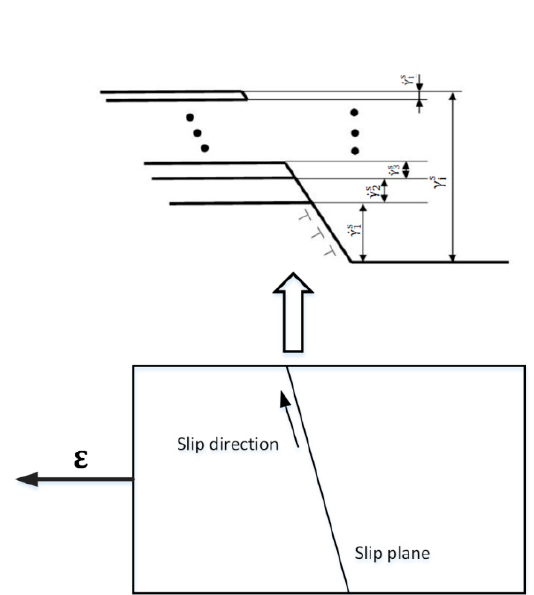
γ  . γ s and the shear strain at and the shear strain at the i